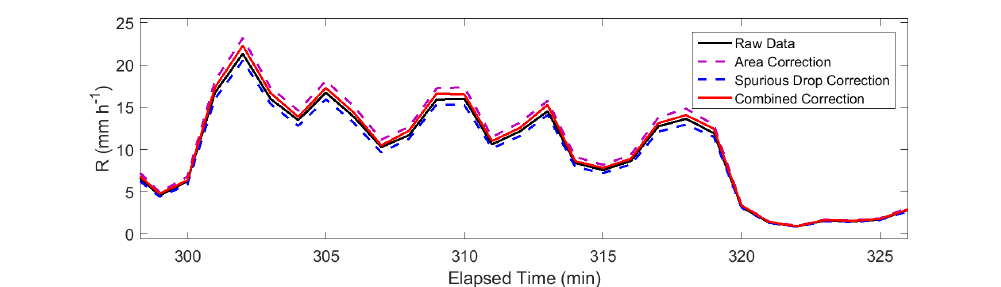
Figure 9. A sub-interval of the rain rates shown in Figure 8. In addition to the raw data and the “combined correction” results, the rain rates looking at each correction individually are shown.